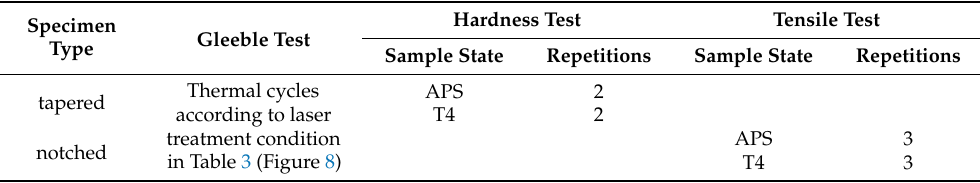
Table 4. Experimental scheme.